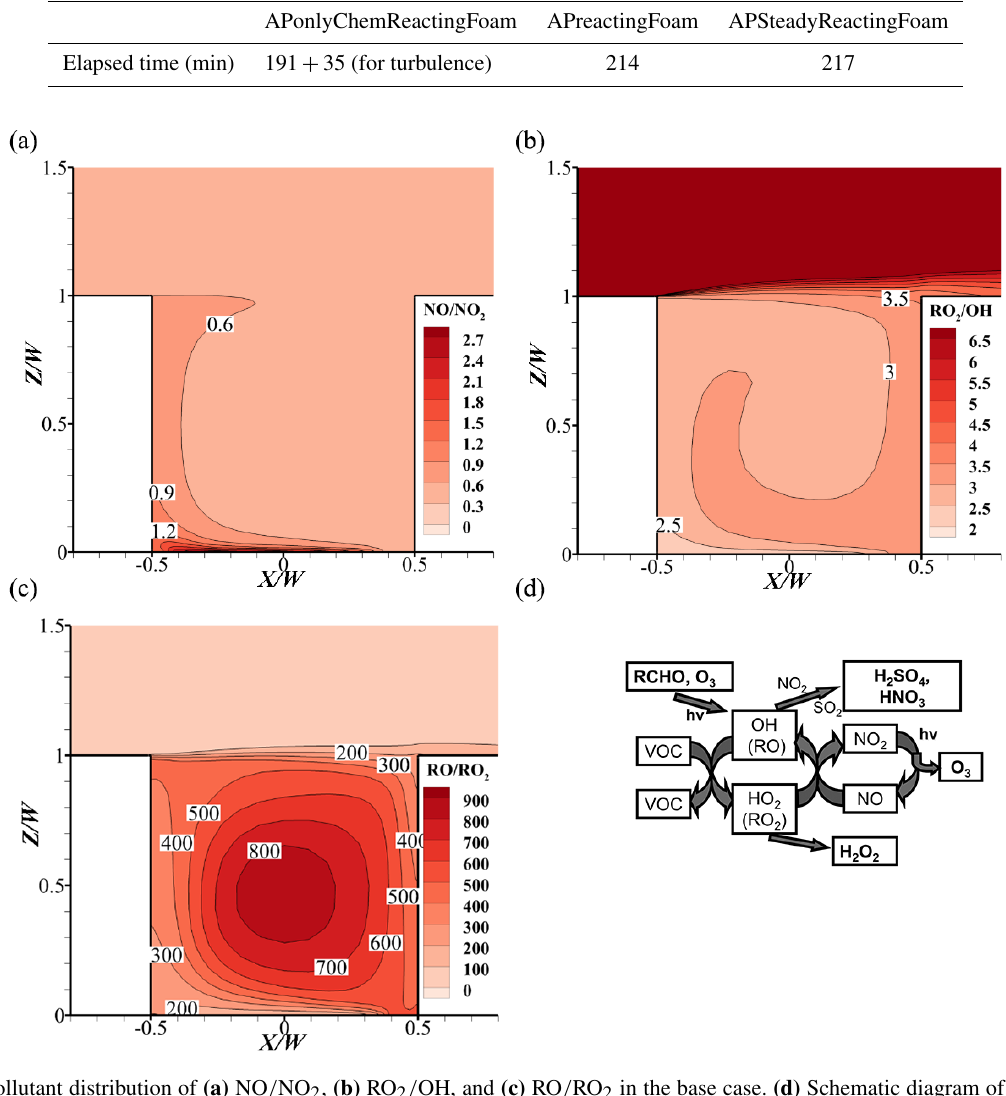
Figure 14. Pollutant distribution of (a) NO / NO 2 , (b) RO 2 / OH, and (c) RO / RO 2 in the base case. (d) Schematic diagram of the formation mechanism of photochemical reactions (Tang et al.,